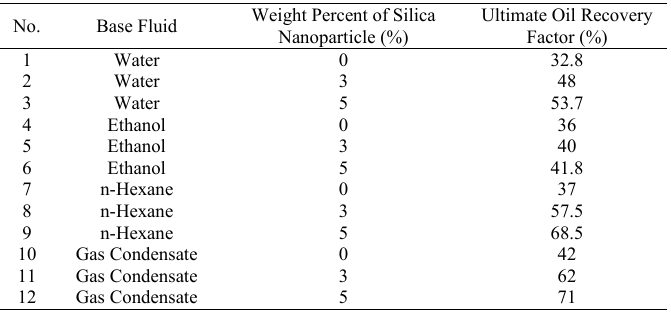
Table 4. List of Designed Injection Tests and the Results No.